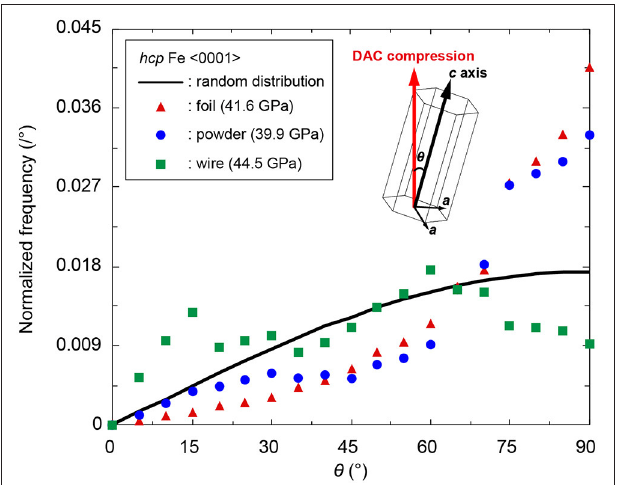
FIGURE 8 | Distribution of angle between < 0001 > and DAC compression axis in three hcp iron samples. Red triangles; hcp iron from foil starting material, blue circles; hcp iron from sintered powder, green squares; hcp iron from wire sample. Black line shows randomly oriented hcp iron. θ is defined as an angle between DAC compression direction and c axis of hcp iron (inset).